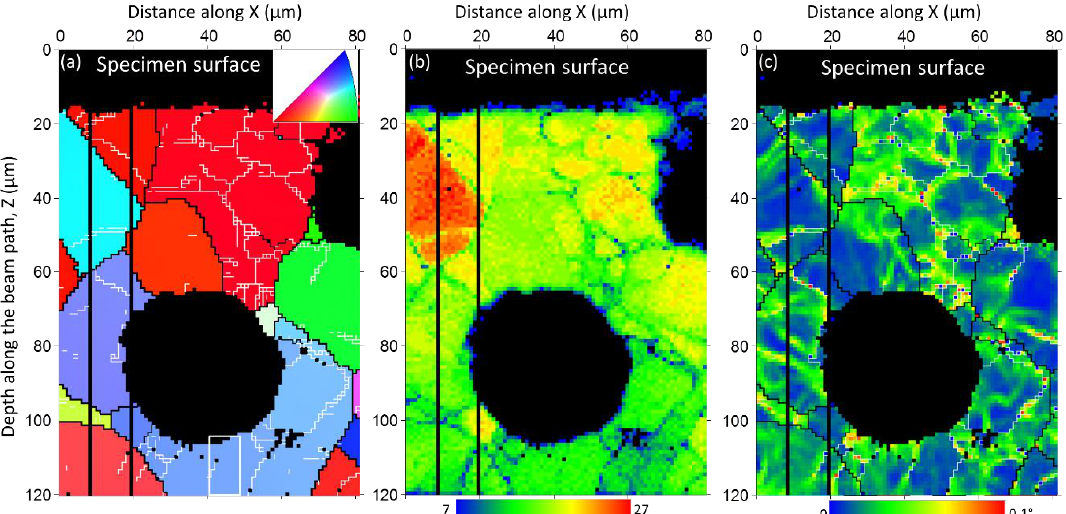
Figure 4. Crystallographic orientation ( a ), number of indexed spots ( b ) and kernel average misorientation (KAM) ( c ) maps showing the details of the microstructure around a graphite nodule (shown as black sphere-like blocks) characterized using polychromatic DAXM. The colors in ( a ) represent the crystallographic orientation along the specimen normal direction (see the inset in ( a )). In the maps, dislocation boundaries with misorientation angles in the range of 0.1–1 ◦ , 1–3 ◦ , and >3 ◦ are shown in thin white, thin black, and thick black lines, respectively. The individual black pixels in the matrix away from the nodules are non-indexed pixels. To reveal in detail the sub-structure within cells, a cut-off angle of 0.1 ◦ is used here for the calculation of KAM values. The white box in ( a ) marks where the monochromatic energy scans were conducted. ( a ) is modified from Figure 4 in [38].